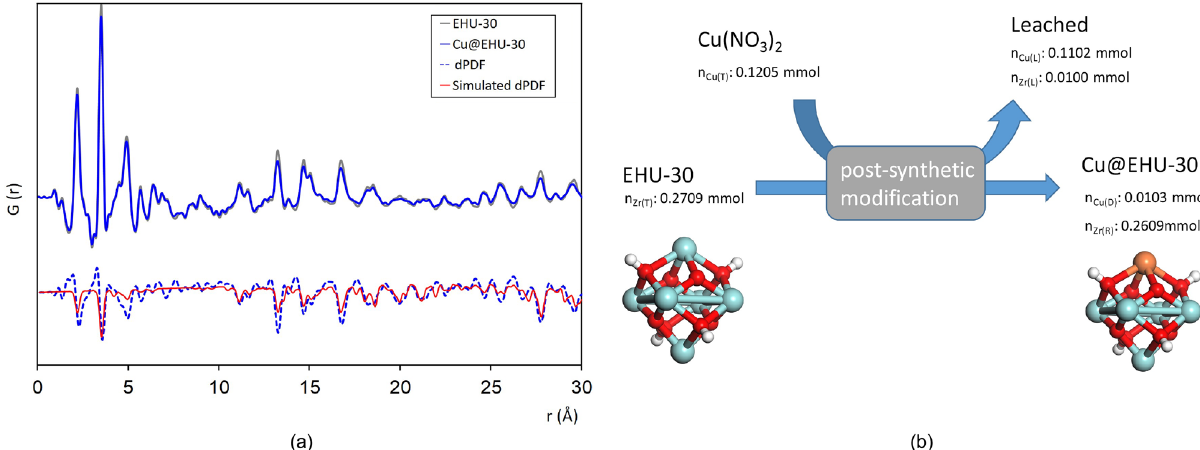
Figure 3. ( a ) Total PDF data of EHU-30 and Cu@EHU-30, and differential PDF signal to highlight changes in intensity. ( b ) Molar balance resulting from the post-synthetic metalation of EHU-30, depicting a representative image of the transmetalation within the inorganic core {M 6 O 4 (OH) 4 } (T: total amount; L: leached; D: doping; R: remanent).